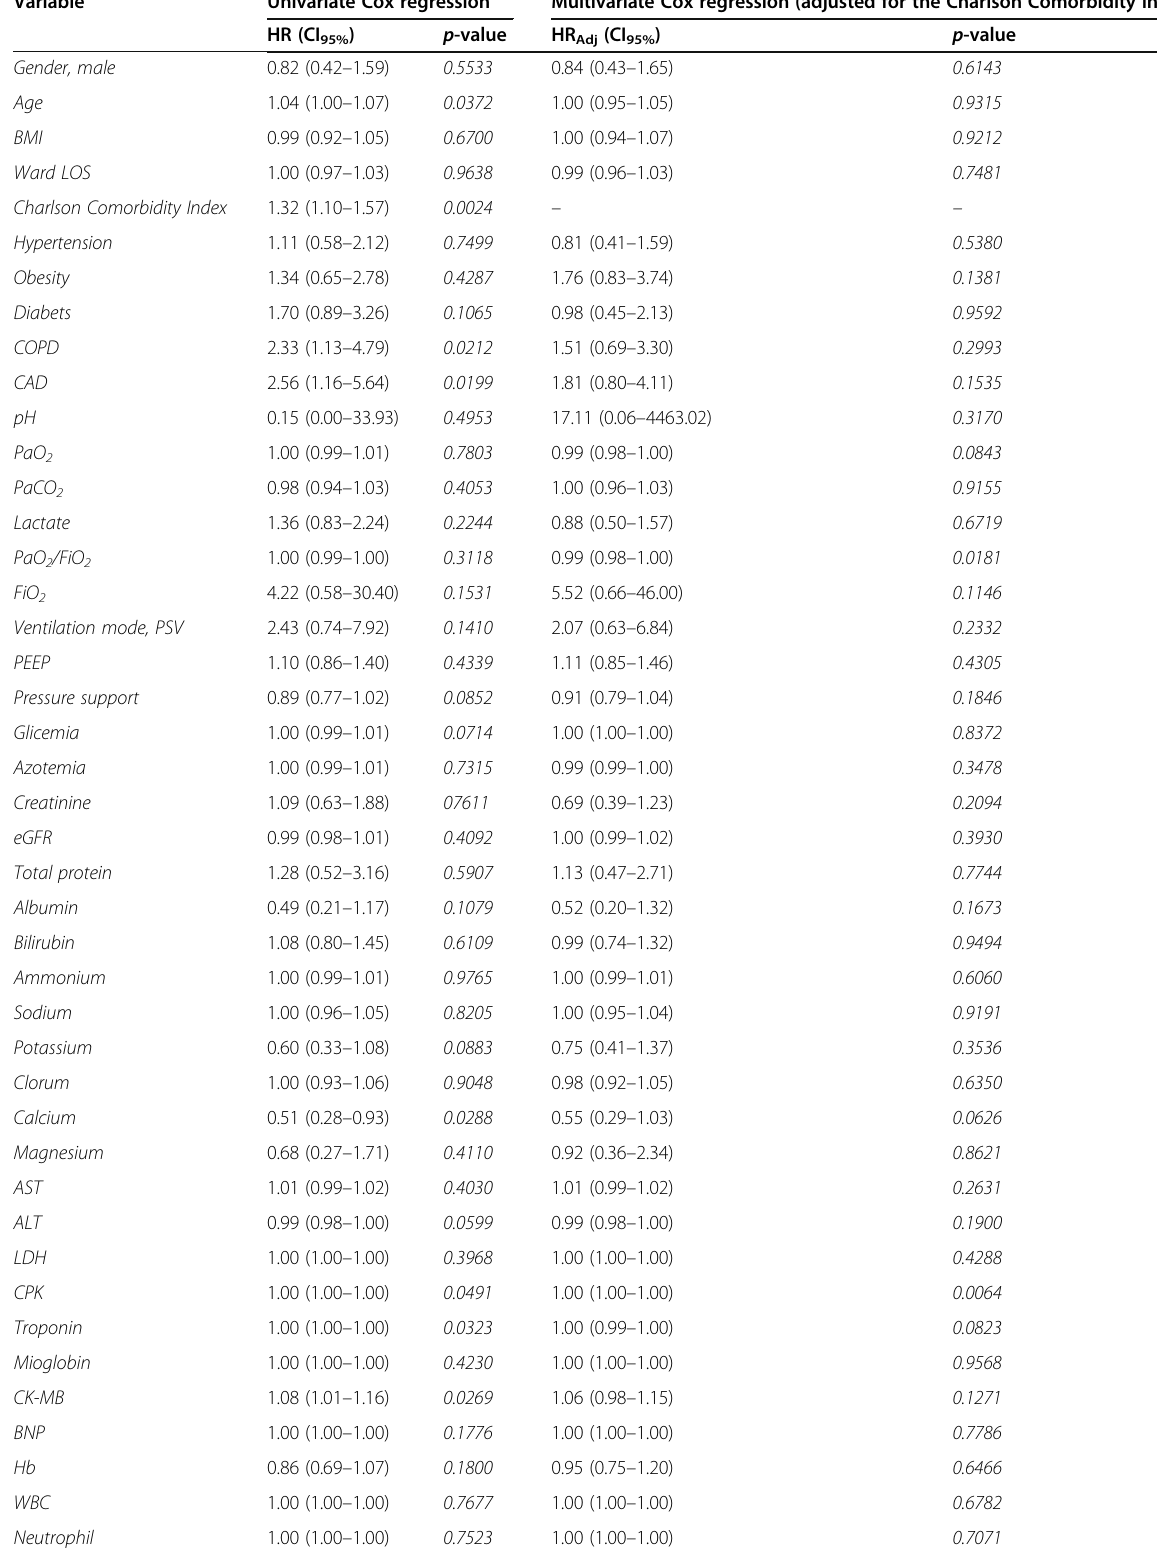
Table 5 Cox regression